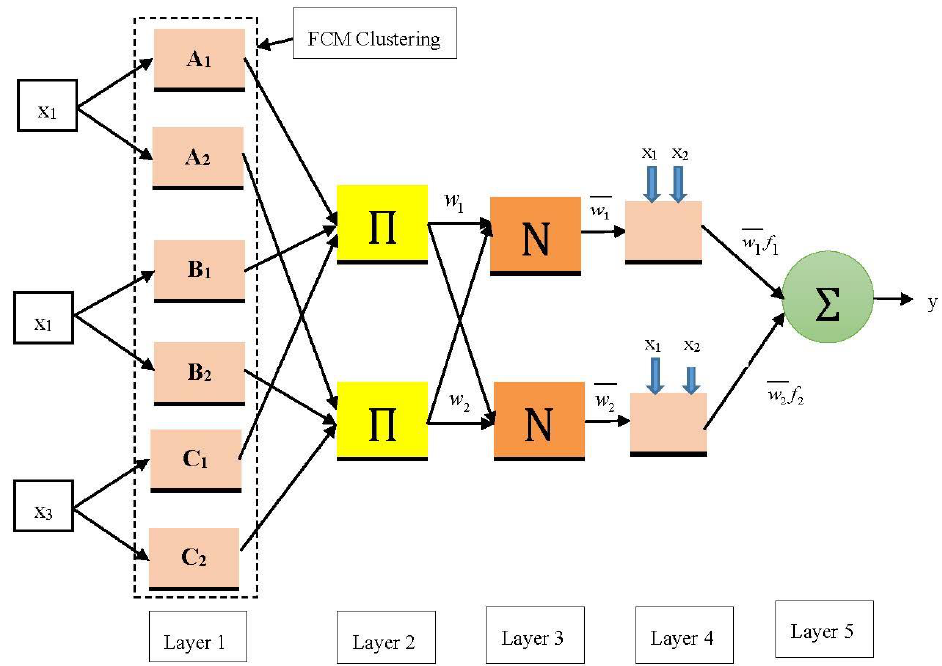
Figure 5. Configuration of the adaptive neuro-fuzzy inference system (ANFIS) [32] .